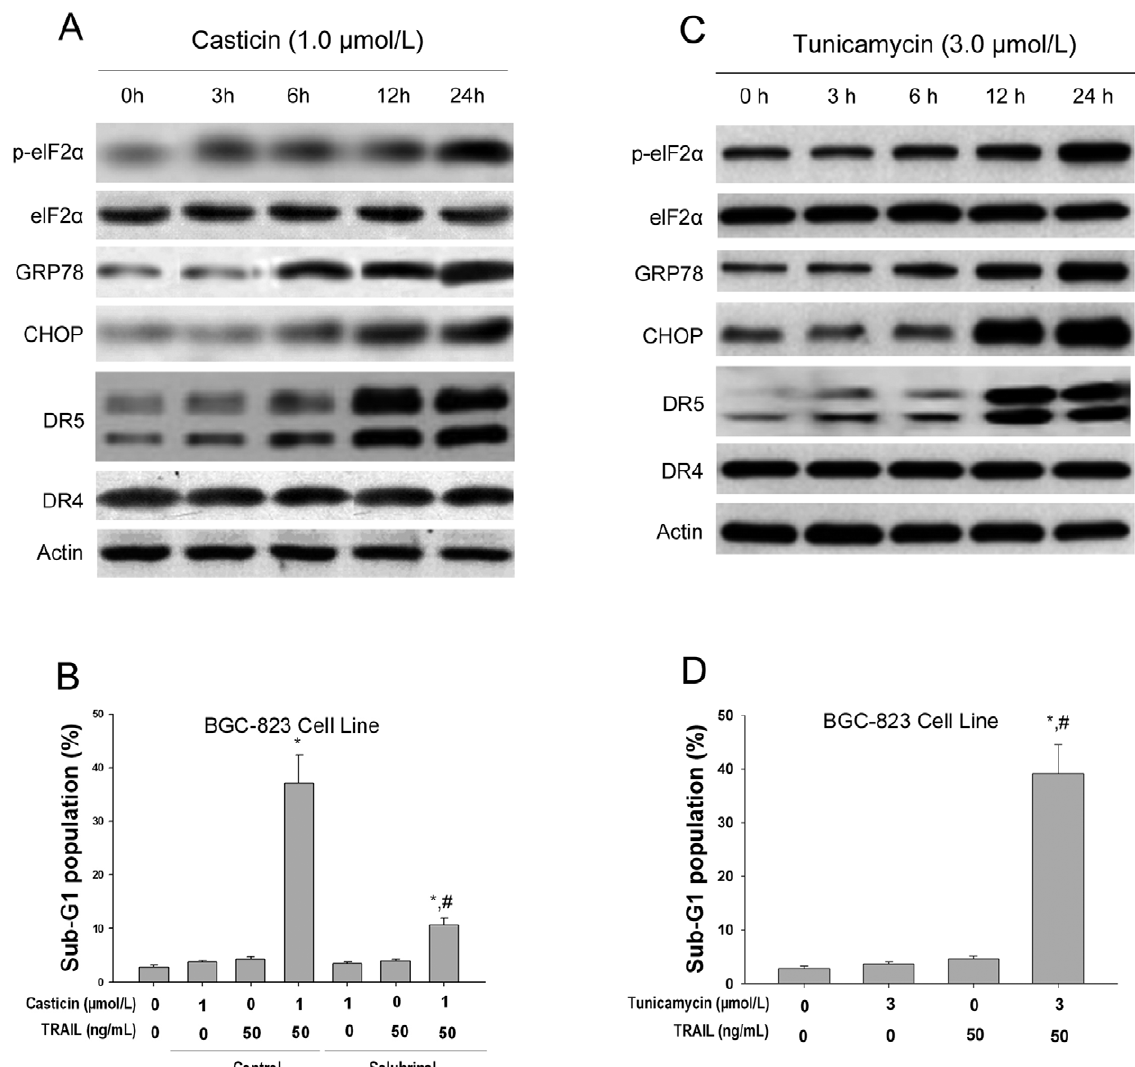
Figure 6. Casticin-induced ER stress in BGC-823 cells. Effects of casticin on the expression levels of ER stress associated proteins (A) using western blot analysis and TRAIL-mediated apoptosis (B) in BGC-823 cells (mean 6 SD, n =3). * P , 0.05 vs. treatment with DMSO; # P , 0.05 vs. treatment with. 1 m mol/l casticin plus 50 ng/ml TRAIL in cells pretreated with 50 m mol/l salubrinal. Effects of tunicamycin on the expression levels of ER stress associated proteins (C) using western blot analysis and TRAIL-mediated apoptosis (D) in BGC-823 cells (mean 6 SD, n =3). * P , 0.05 vs. treatment with DMSO; # P , 0.05 vs. treatment with.